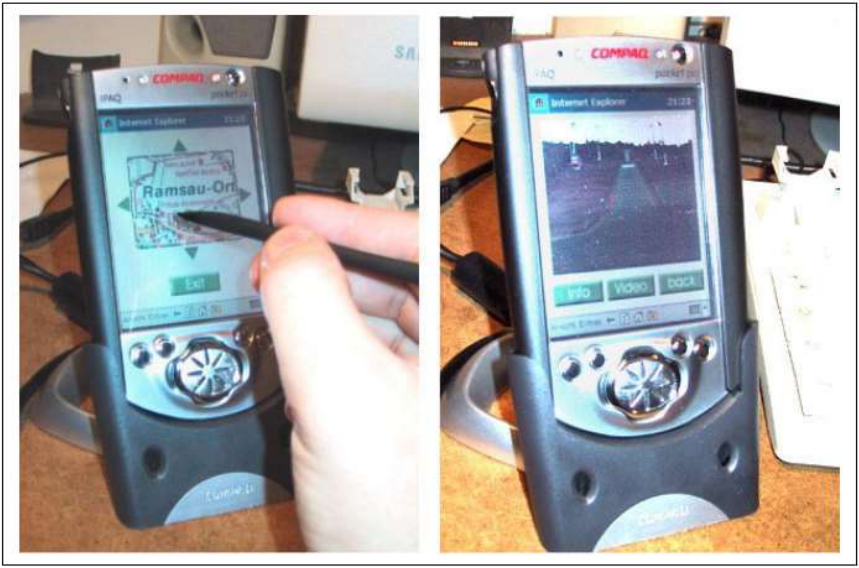
Figure 6. Travel information in the iPAQ application (Source: Almer & Stelzl,